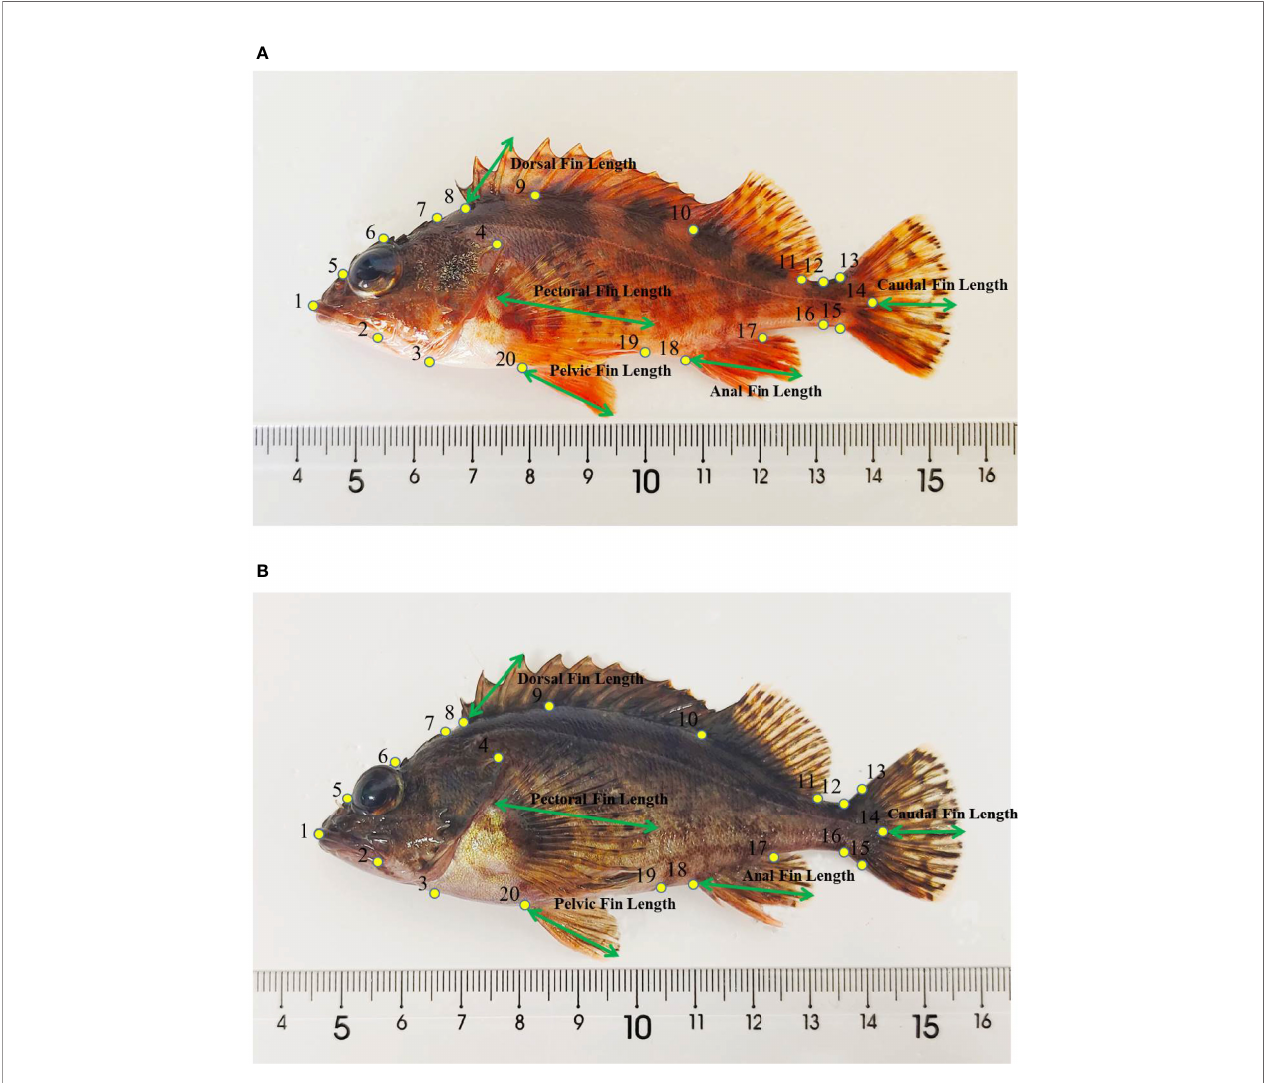
FIGURE 1 | Positions of the 20 landmarks used for measurement of morphology in wild (A) and hatchery-reared (B) marbled rock fi sh. 1: anterior tip of premaxilla; 2: most posterior point of maxilla; 3: insertion of the operculum on the ventral pro fi le; 4: most posterior point of the operculum; 5: spine in front of orbit; 6: spine behind the orbit; 7: spine closest to the anterior base of the dorsal fi n; 8: anterior base of the fi rst dorsal fi n; 9: vertex of the back; 10: anterior base of the second dorsal fi n rays; 11: posterior base of dorsal fi n; 12: deepest point of caudal peduncle at dorsal outline; 13: anterior attachment of dorsal membrane from caudal fi n; 14: base of middle caudal rays; 15: anterior attachment of ventral membrane from caudal fi n; 16: uppermost point of caudal peduncle at ventral outline; 17: posterior base of anal fi n; 18: anterior base of anal fi n; 19: anus; 20: semi-landmark collected along the ventral pro fi